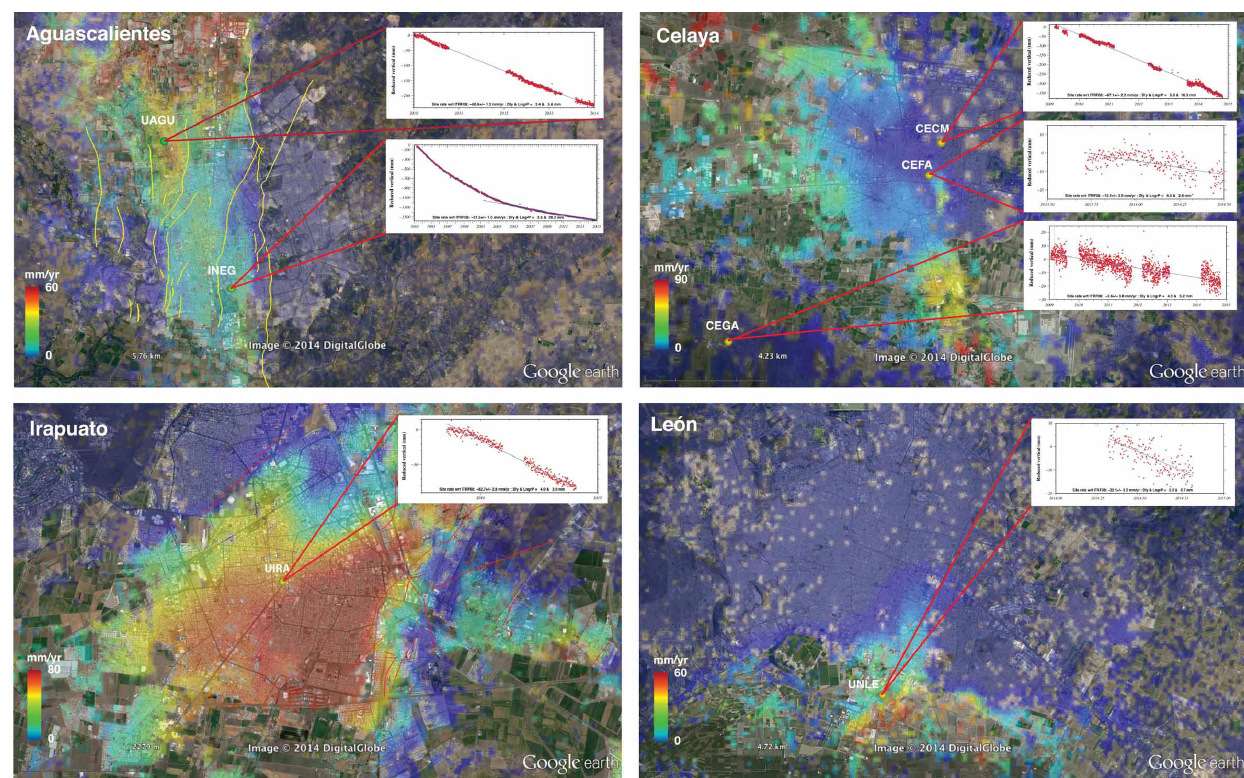
Figure 1. Ground subsidence velocity maps (modified from Chaussard et al., 2014) and cGPS vertical component time series for the cities of Aguascalientes, Celaya, Irapuato, and